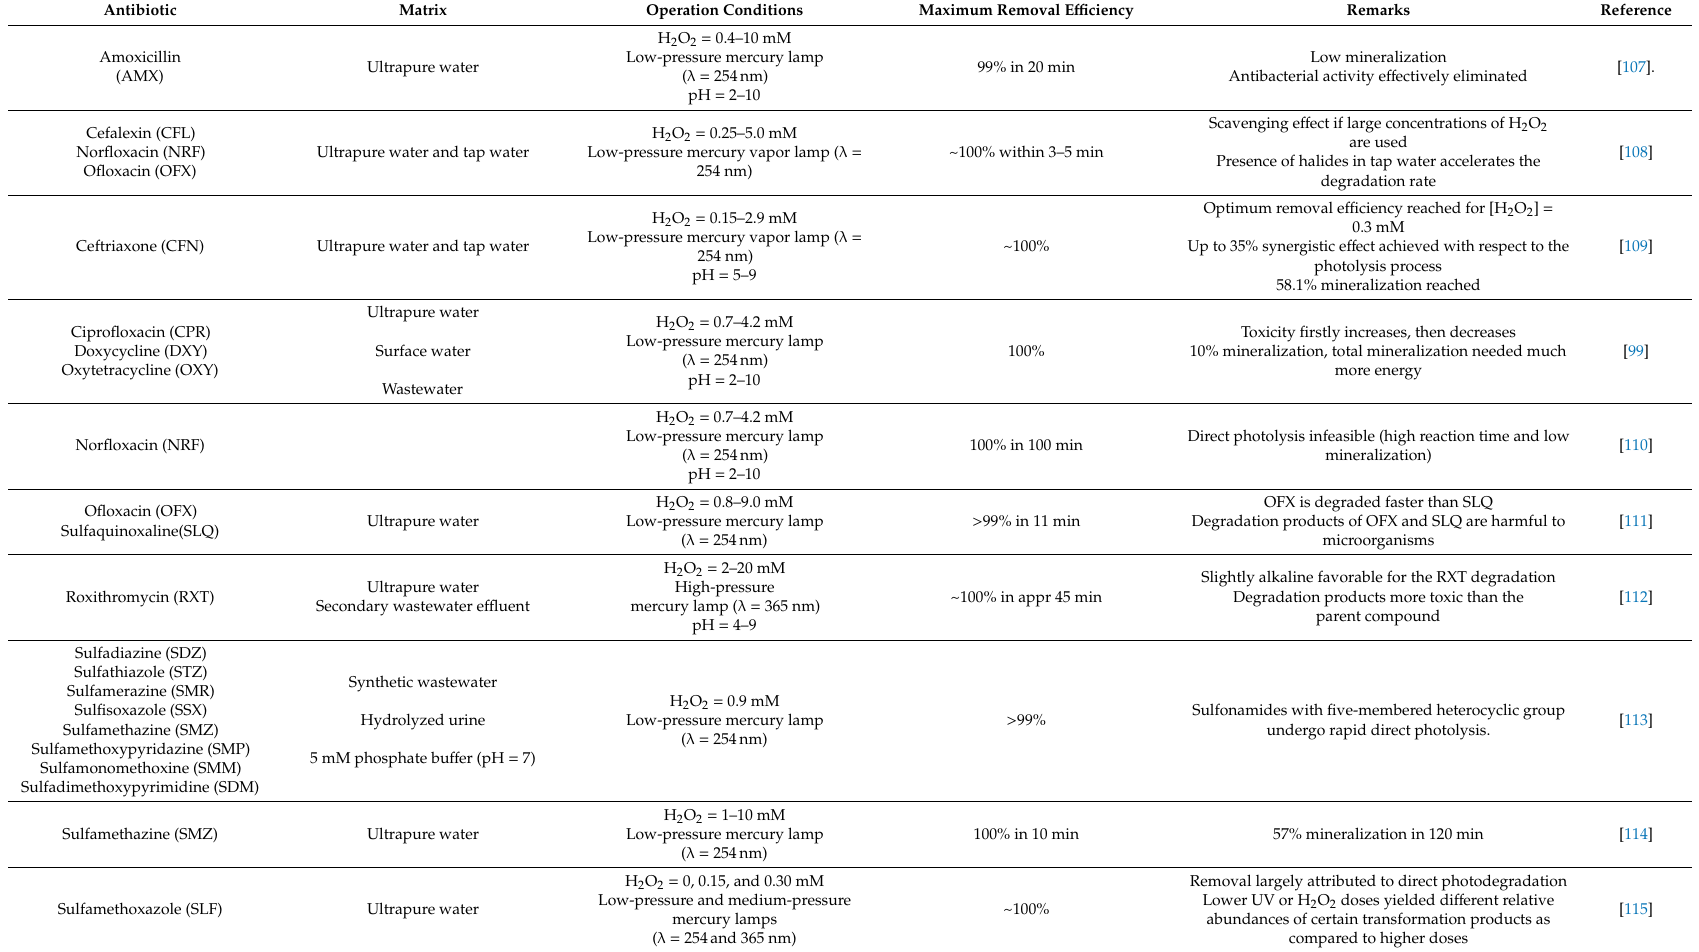
Table 9. Removal e ffi ciency of antibiotics in waters by the H 2 O 2 / UV